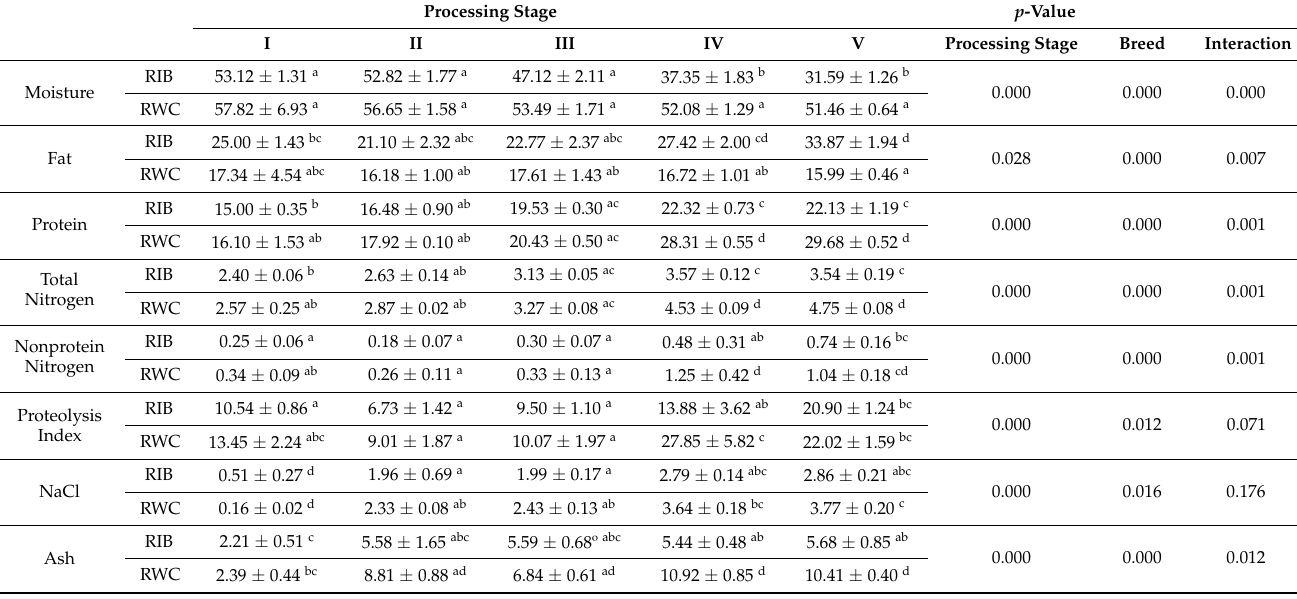
Table 1. Effect of processing stage and breed on the physicochemical parameters and salt content of boneless dry-cured ham. Results are expressed in g/100 g of product (means values ± SEM). Processing Stage p